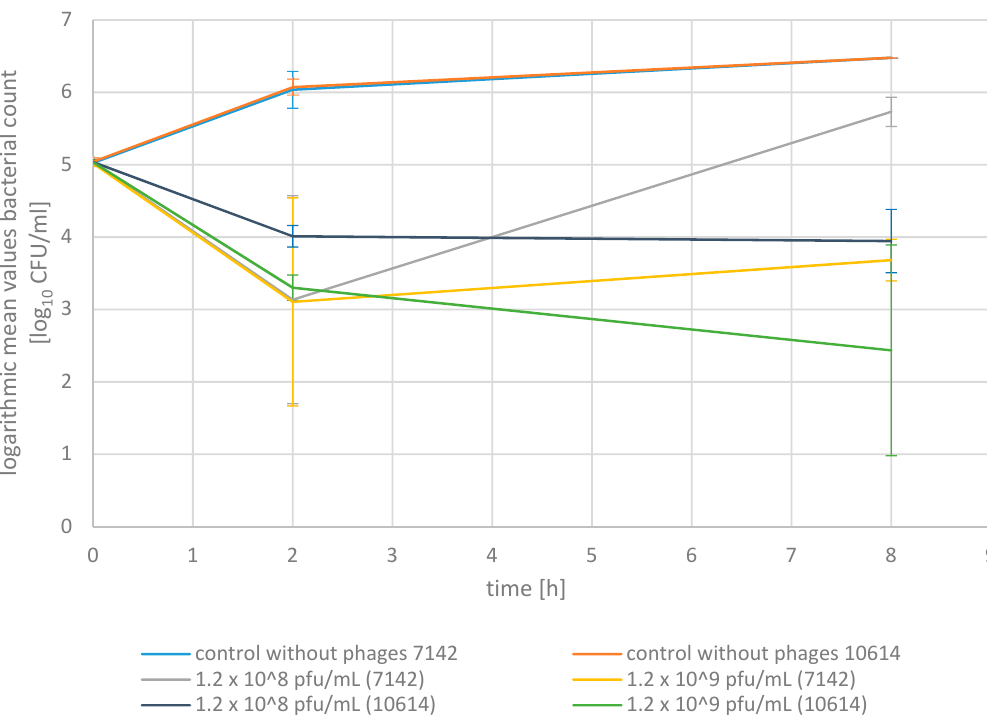
Figure 3. Bactericidal activity of a phage mixture in pasteurized milk with standard deviations. The mean germ density (log 10 cfu / mL) of the two S. aureus isolates 7142 and 10614, respectively, for the control culture without phages (blue: 7142; orange: 10614), the assays with the addition of 0.1 mL phage mixture at a final concentration of 1.2 × 10 8 pfu / mL (grey: 7142; violet:10614) and 1 mL phage mixture at a final concentration of 1.2 × 10 9 pfu / mL (yellow: 7142; green: 10614). Inoculation with S. aureus at a concentration of averagely 1.1 × 10 5 cfu / mL. Dilution series were limited at 3.0 × 10 6 cfu / mL for the investigation in pasteurized